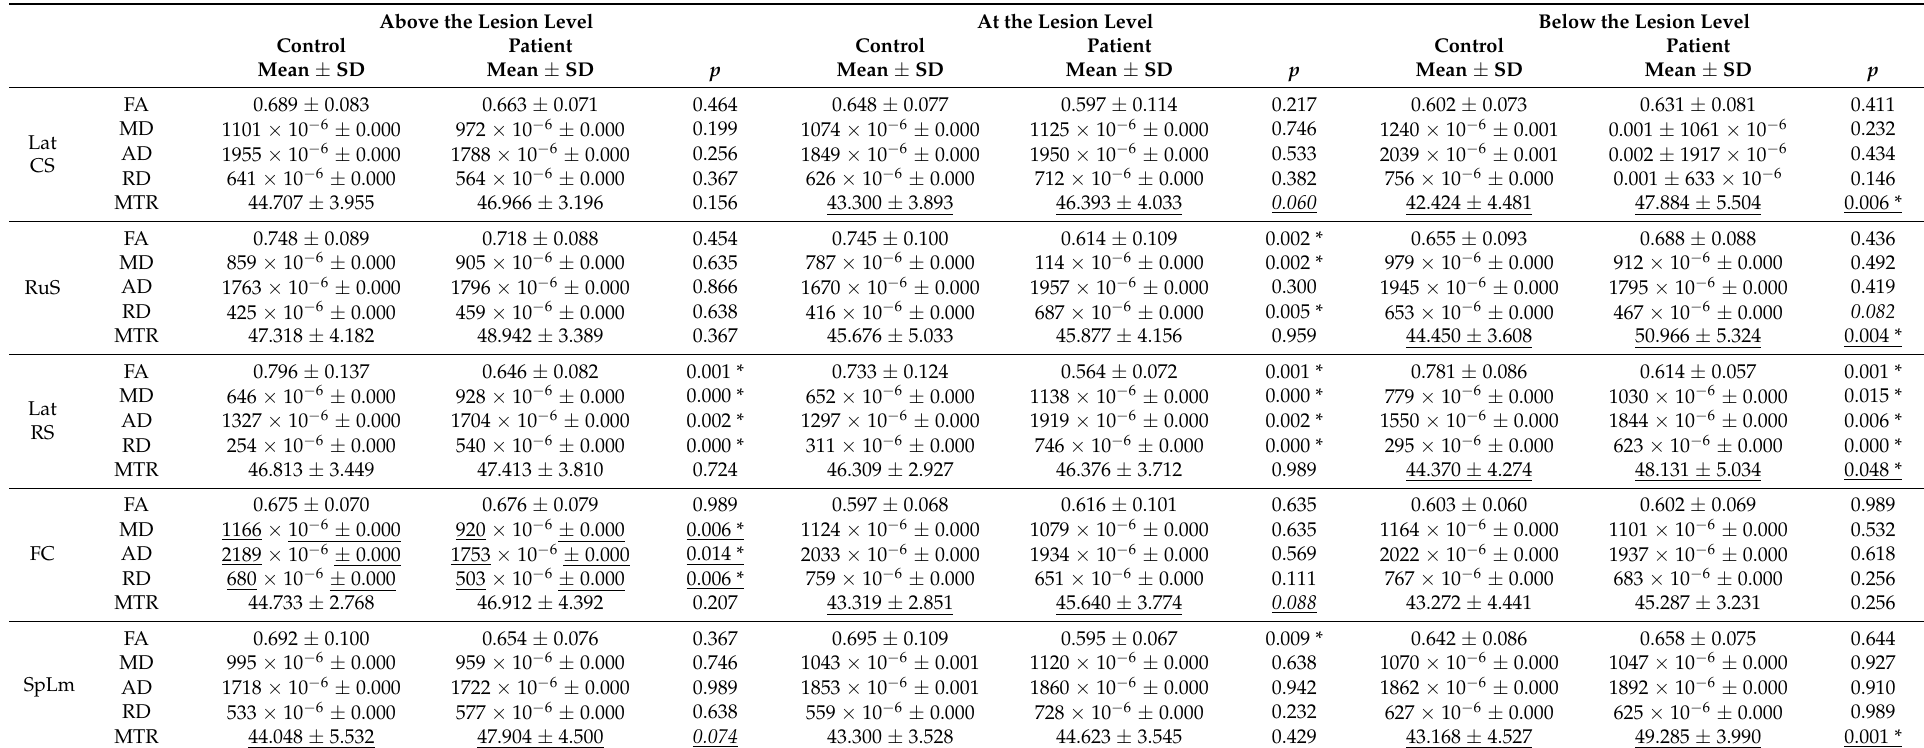
Table 3. Group differences of MR parameters of spinal cord tracts at each